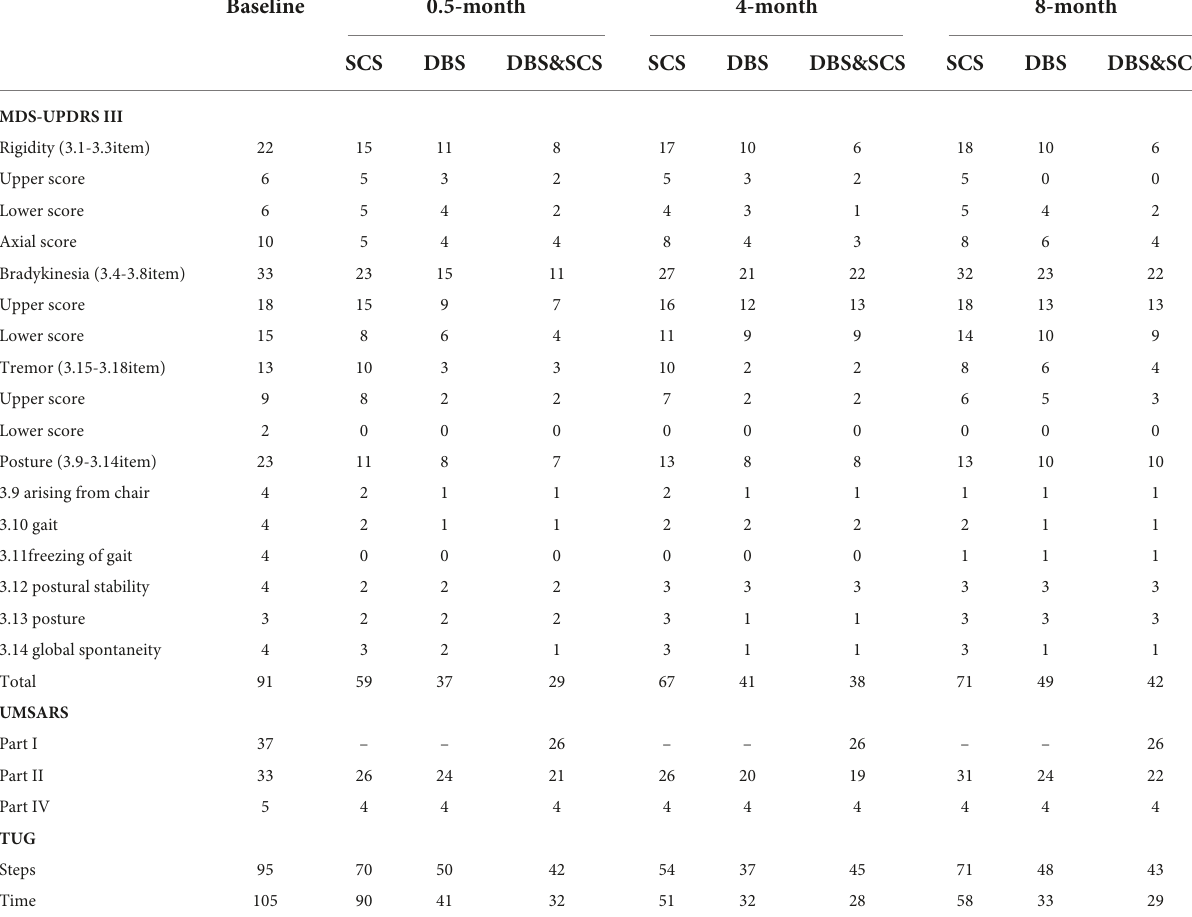
TABLE 1 The outcomes of the double-blind evaluation of the MDS-UPDRS III, UMSARS I, II, IV, and TUG held at baseline and 0.5- (phase I trials), 4-, and 8-month